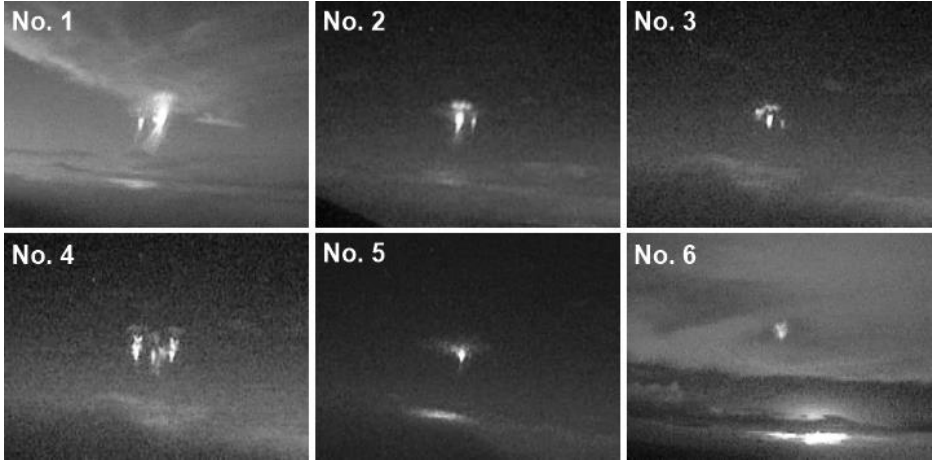
Figure 2. All sprite events on 22 July 2013 were observed from the summit of Mt. Fuji. The images are enlarged.